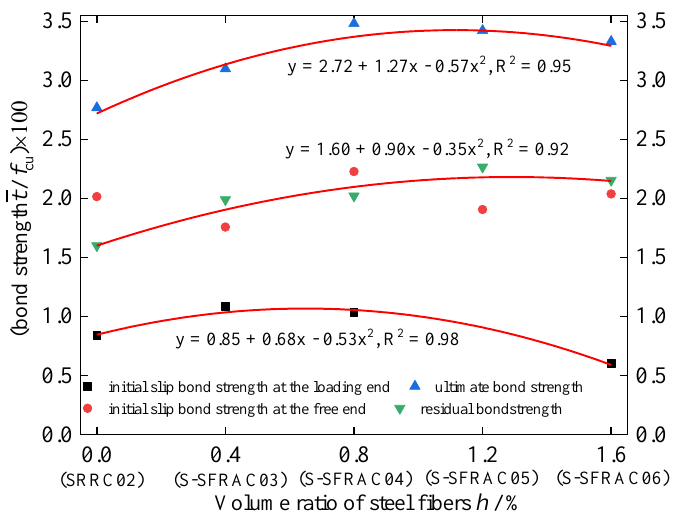
Figure 16. Relationship between the bond strength and volume ratio of the steel fibers.